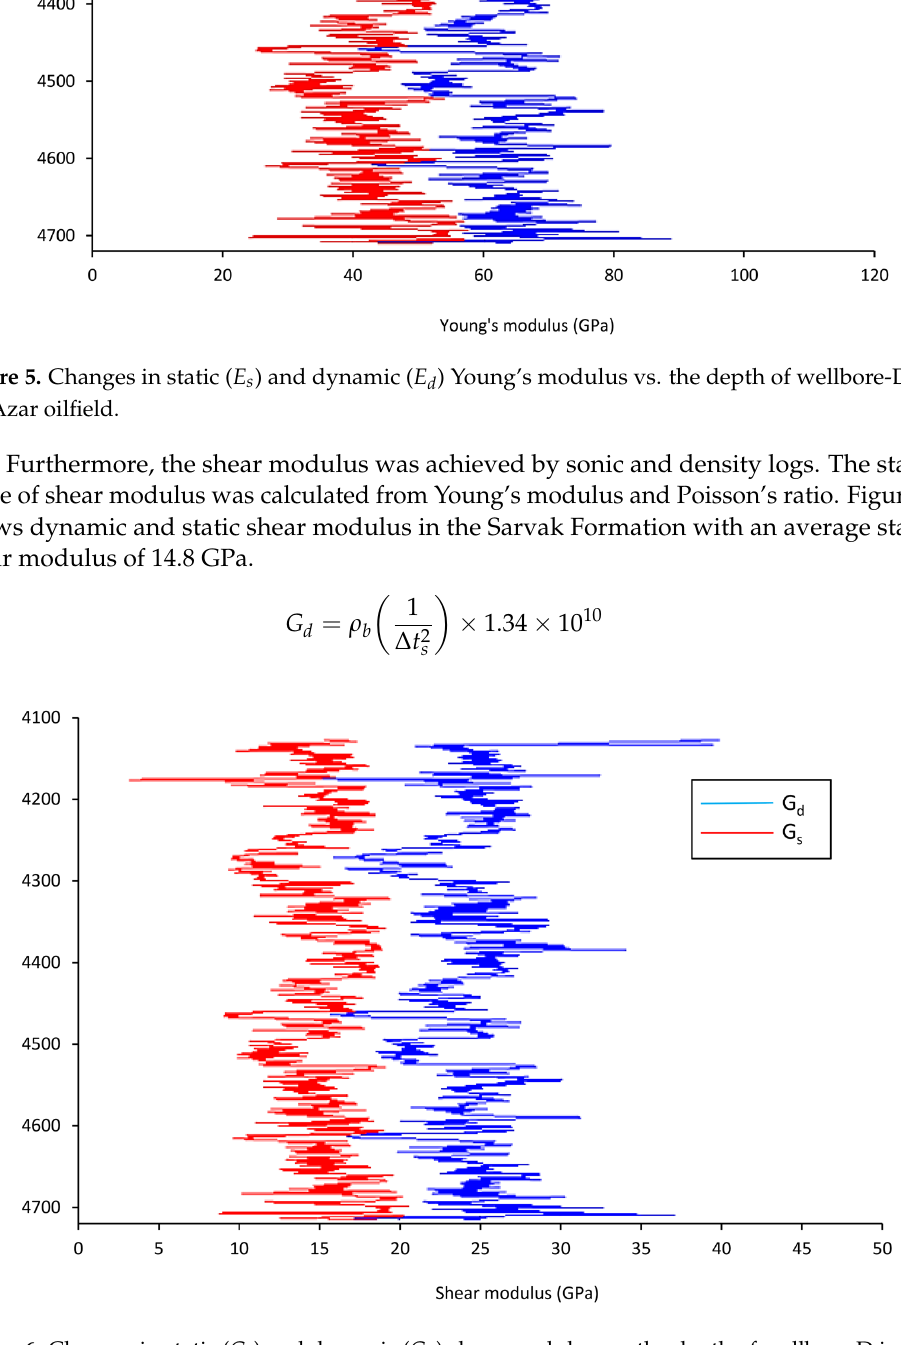
Figure 6. Changes in static ( G s ) and dynamic ( G d ) shear modulus vs. the depth of wellbore-D in the Azar oilfield.